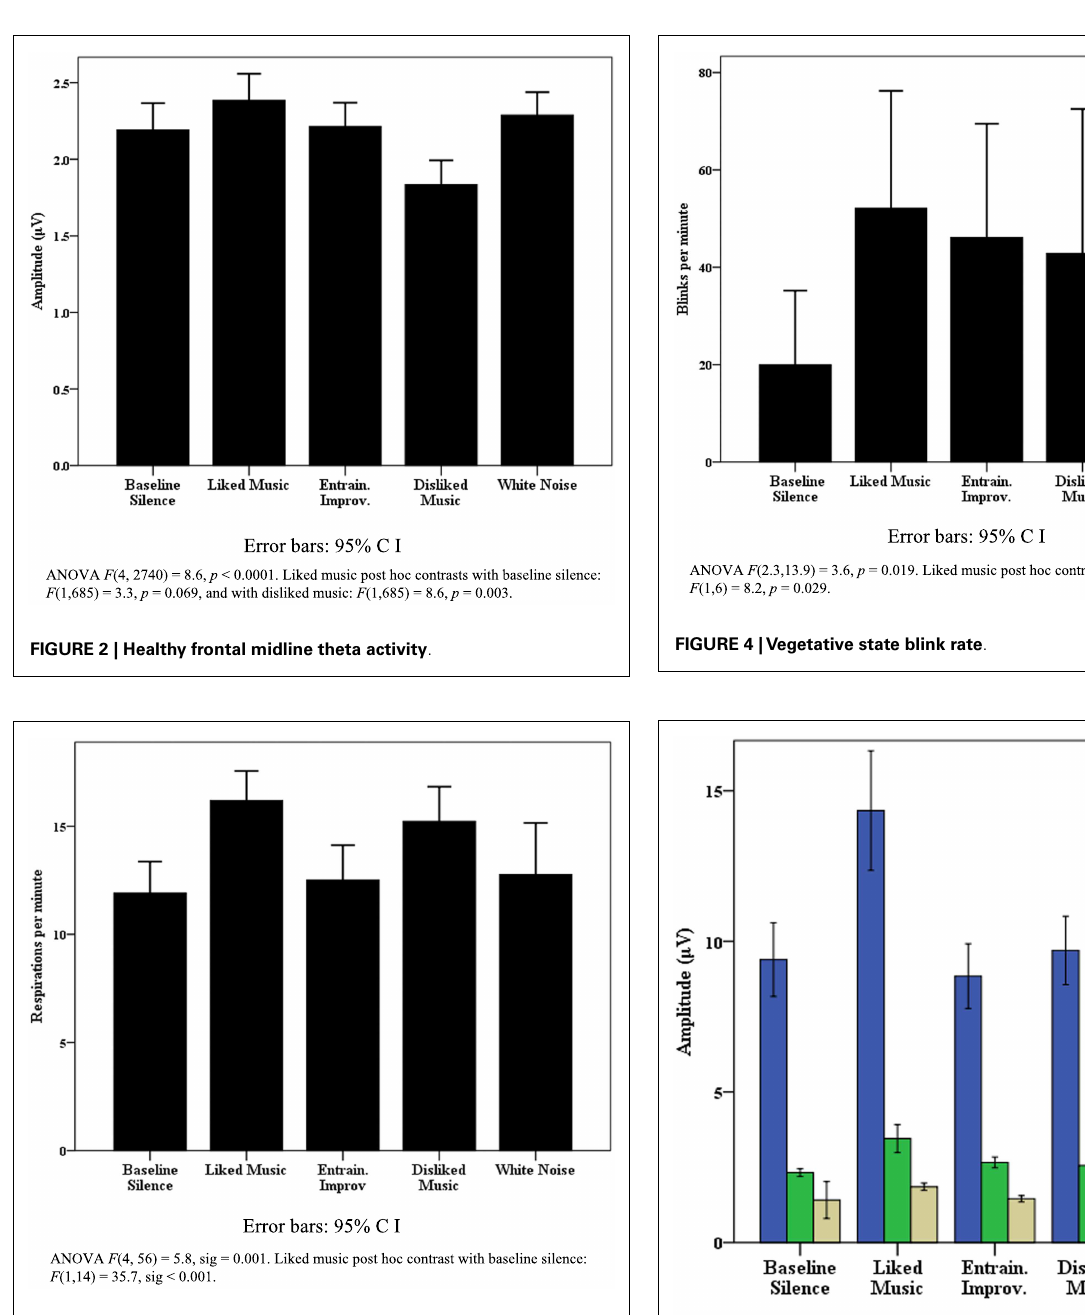
FIGURE 3 | Healthy respiration rates .